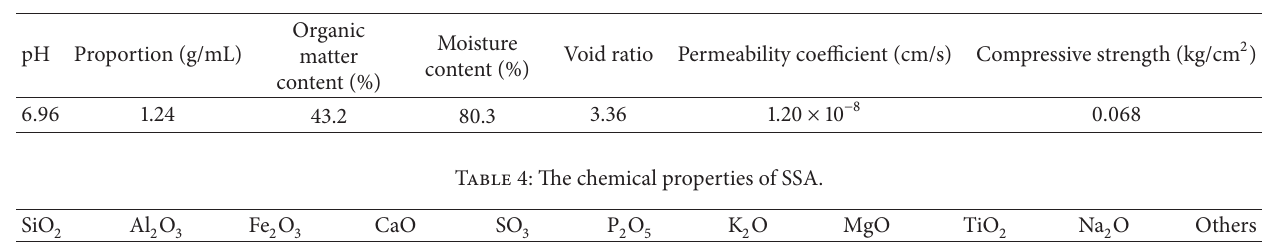
Table 3: The basic physical property indexes of sewage sludge.